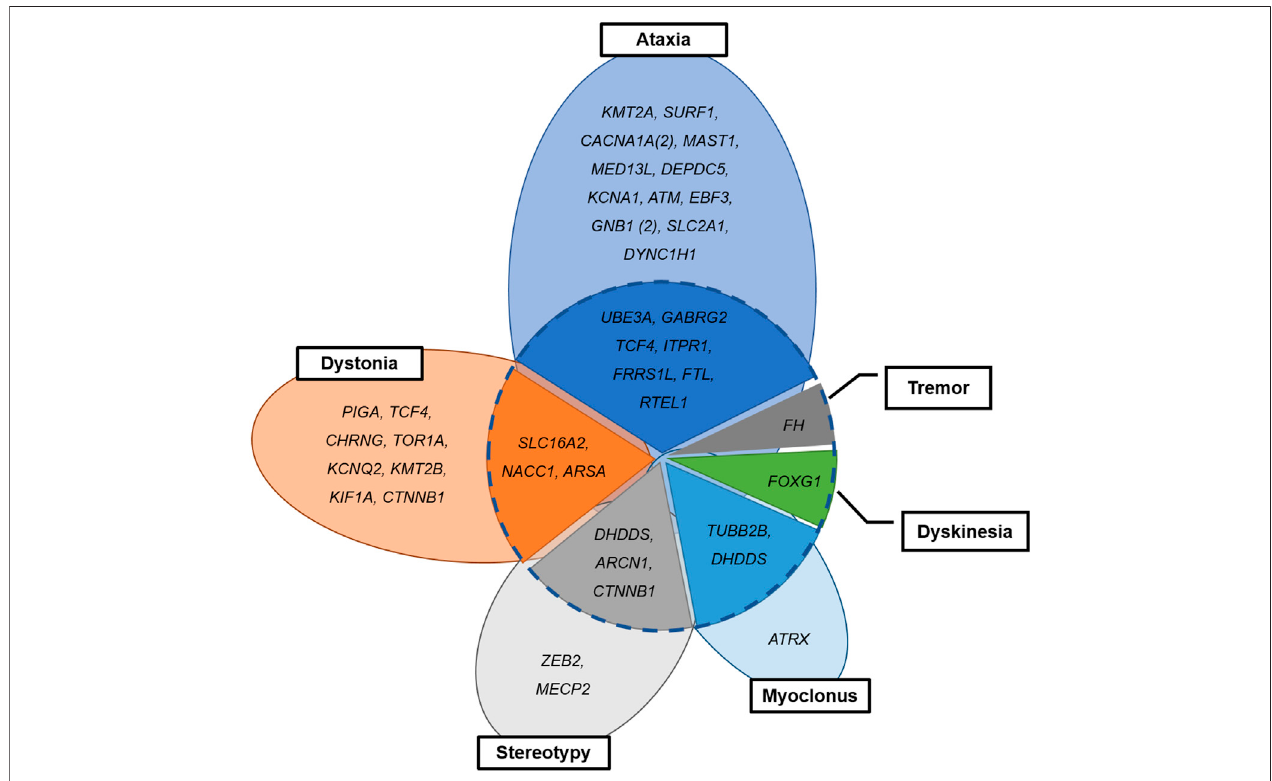
FIGURE 3 | Combined or separated movement phenomenology in patients with neurogenetic disease. Dotted circle: combined (inside) and separate phenotypes (outside).